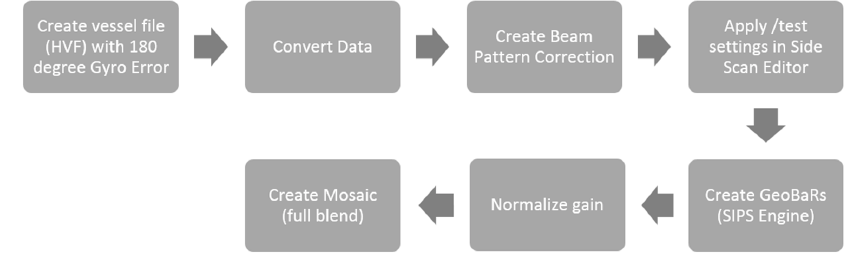
Figure 5. Processing workflow for under ice acoustic backscatter processing.